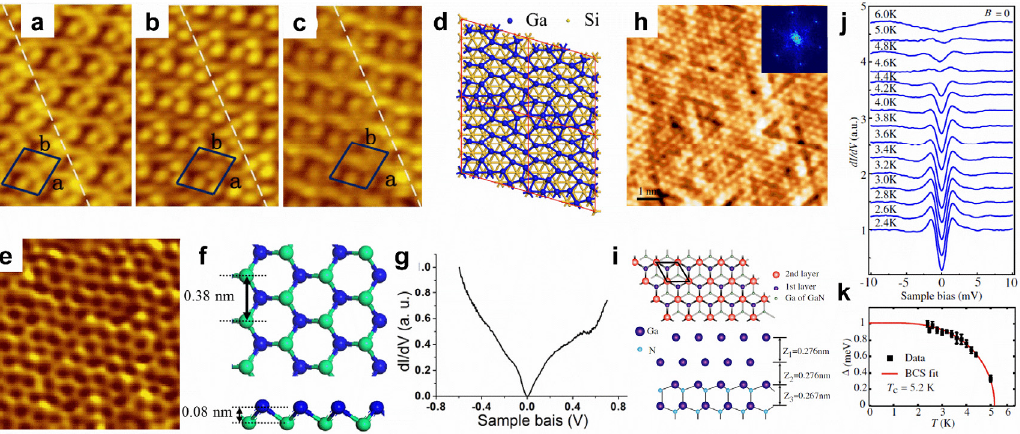
Figure 5. Surface modifications of gallenene. ( a – c ) STM images with biases of 2.0, 1.6, and 1.0 V of monolayer gallenene on Si(111) substrate. ( d ) Proposed configuration of monolayer gallenene on Si(111). ( e ) STM image of second-layer gallenene on Si(111) substrate. ( f ) Top and side views of the proposed structure for second-layer gallenene. ( g ) dI/dV spectrum recorded on the second-layer gallenene. ( h ) High-resolution STM image of gallenene on GaN(0001) substrate. ( i ) Top and side views of proposed gallenene structure on GaN(0001) substrate. ( j ) A series of dI/dV spectra recorded on gallenene/GaN at various temperatures. ( k )Temperature-dependent superconducting gap magnitude and fitting to BCS gap function for gallenene/GaN. ( a – g ) Reprinted with permission from Ref. [110]. Copyright 2018, IOP Publishing Ltd. ( h – k ) Reprinted with permission from Ref. [111]. Copyright 2015, American Physical Society.